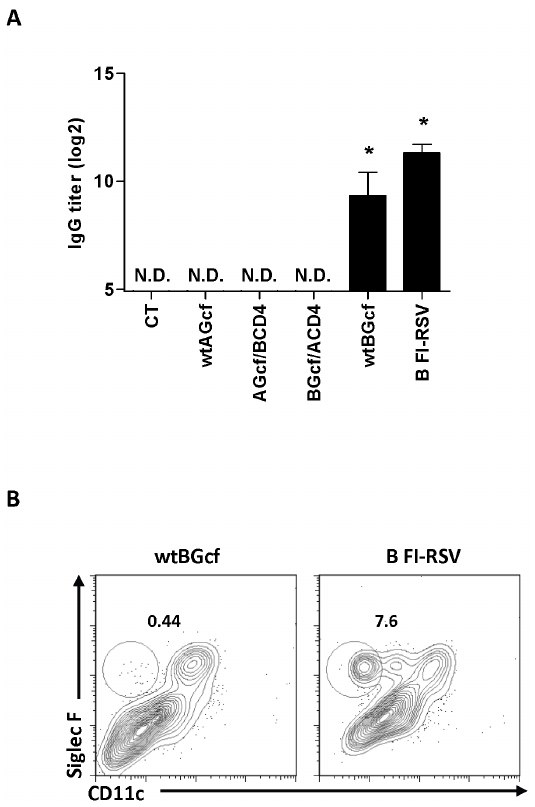
Figure 3. Antibody production and eosinophilia in mice immunized with wtBGcf. Mice were immunized twice with 20 m g of wtAGcf, AGcf/BCD4, BGcf/ACD4, or wtBGcf in the presence of 2 m g of CT or CT alone sublingually or with 1 6 10 5 PFU of B type FI-RSV through foot-pad route. (A) RSV B type specific serum IgGs were measured by ELISA 13 days after the second immunization. (B) For the pulmonary eosinophilia, mice were immunized twice with 20 m g of wtBGcf in the presence of 2 m g of CT sublingually or with 1 6 10 5 PFU of B type FI-RSV through foot-pad route. At day 4 post challenge with 2 6 10 6 PFU of CH18537, the pulmonary eosinophils were detected by flow cytometry. The results are expressed as mean + S.E.M. for the group (n=3). The data are representative of three separate experiments. Significant differences from results with the CT are *, P , 0.05.